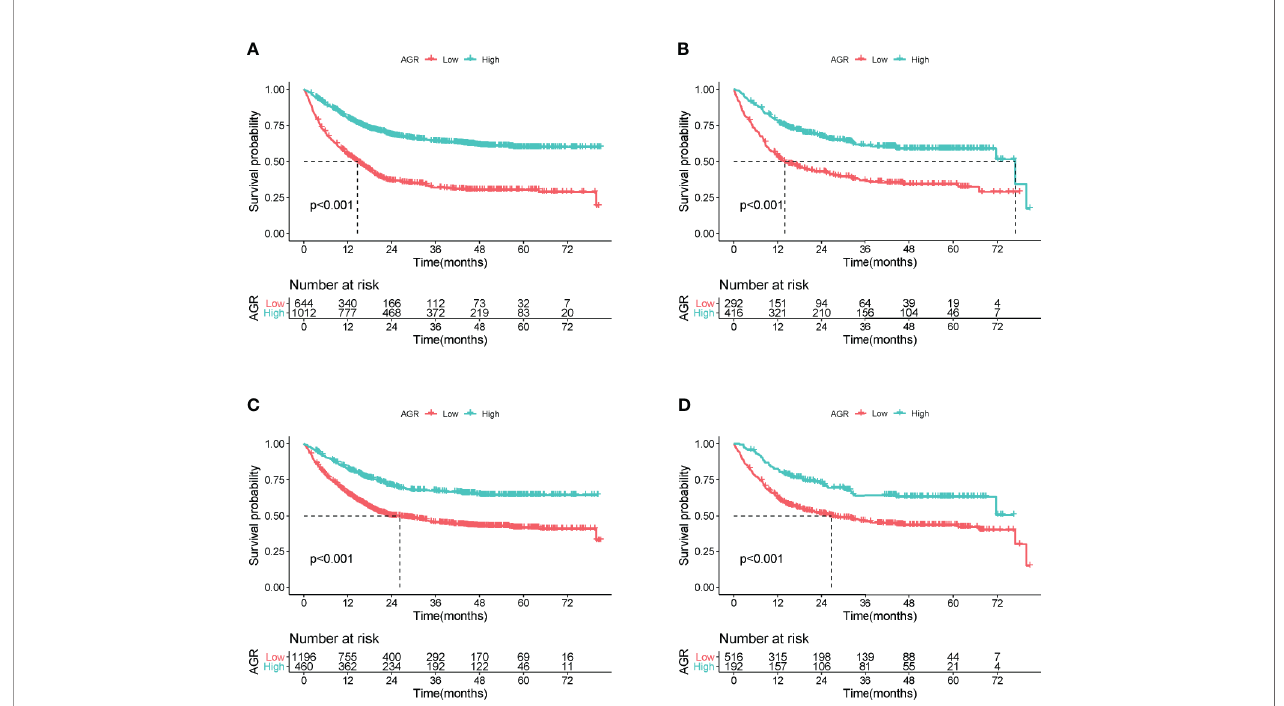
FIGURE 3 | Overall survival of cachexia patients by cutoff of AGR in training and validation cohort. (A) AGR cutoff of 1.24 at training cohort. (B) AGR cutoff of 1.24 at validation cohort. (C) Reference AGR cutoff of 1.5 at training cohort. (D) Reference AGR cutoff of 1.5 at validation cohort. AGR, albumin – globulin ratio.